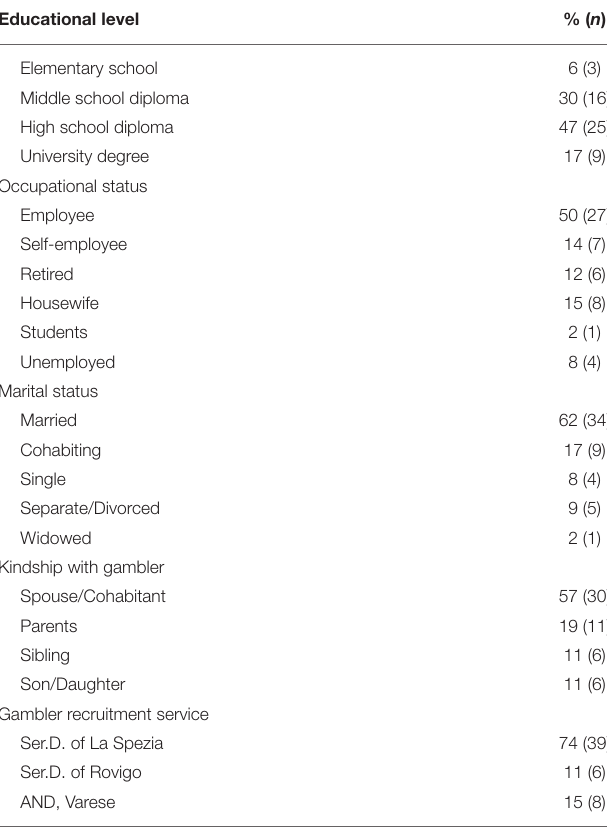
TABLE 2 | Gamblers’ occupational status, kindship with the affected family member, recruitment service, level of treatment and most practised gambling